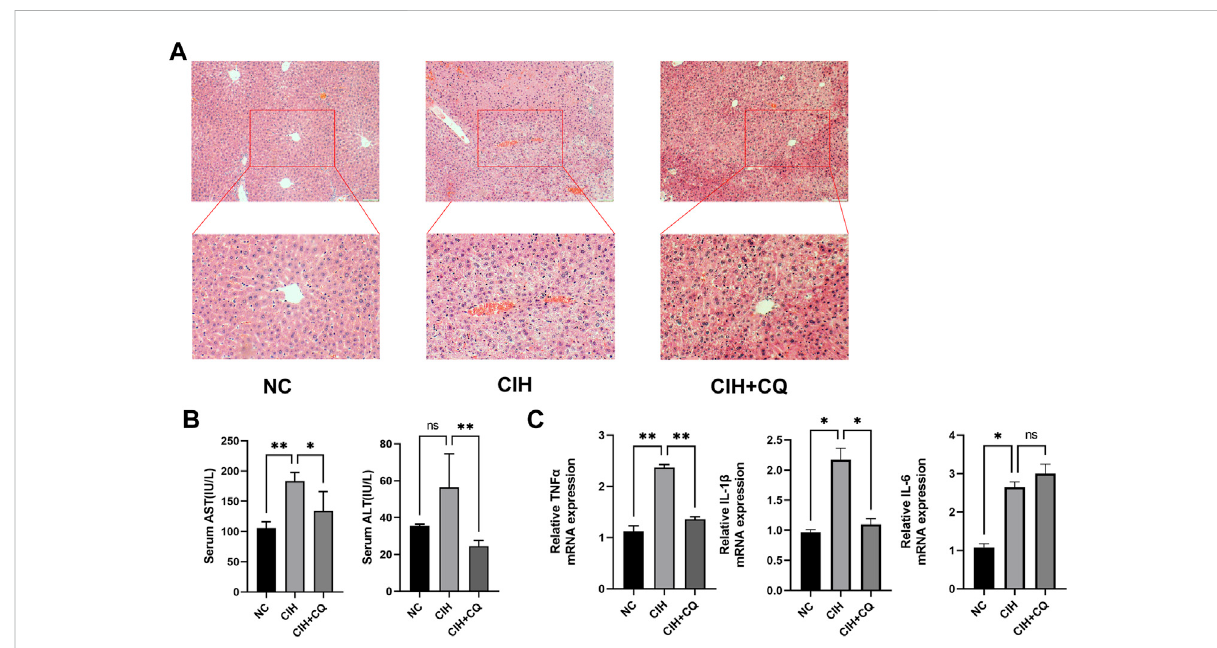
FIGURE 6 Inhibition of autophagic fl ux alleviates CIH-induced hepatocellular in fl ammation. (A) H&E staining of hepatic tissues from mice in the indicated groups (Scale bars: 100 and 50 μ M). (B) Serum ALT and AST were compared among groups. (C) Hepatic IL-1 β , IL-6, and TNF- α mRNA levels were compared among groups (* p < 0.05, ** p < 0.01, ns: no statistical